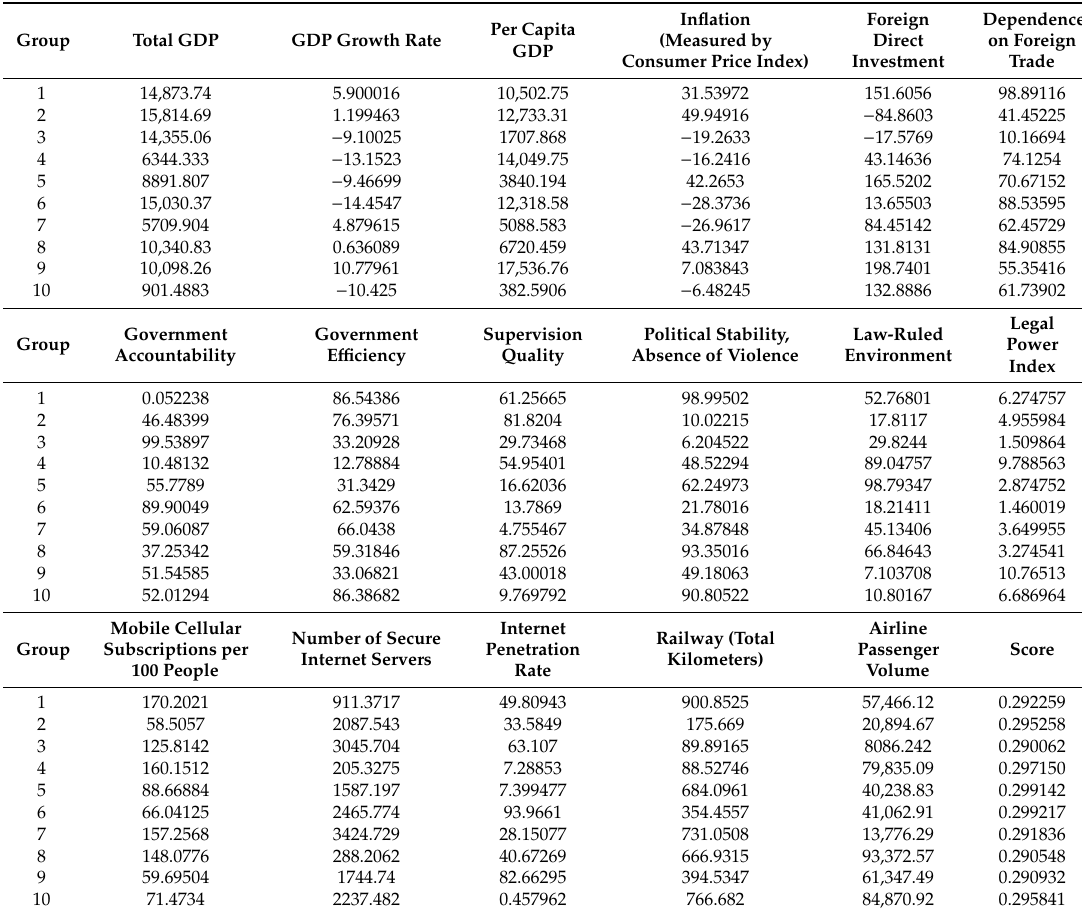
Table 4. Optimal indicator combinations.